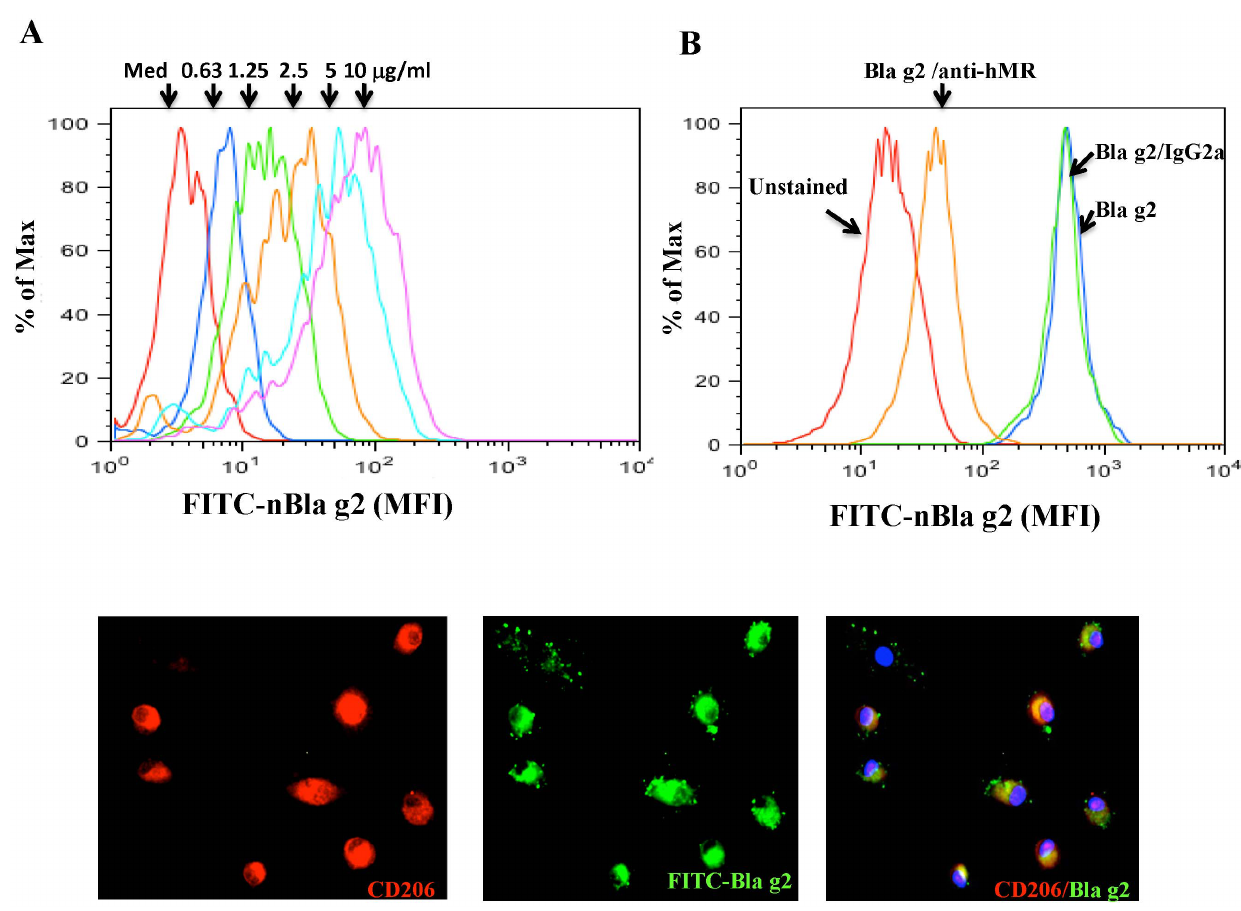
Figure 4. CD206 mediates Bla g 2 uptake by fibrocytes. ( A ) Different doses of the FITC labeled purified Bla g 2 were co-incubated with fibrocytes for 1 h at 37 u C, Bla g 2 uptake was detected by flow cytometry (Colors represent different doses as indicated). ( B ) The Bla g 2 uptake (blue line) was significantly inhibited when cells were pre-incubated with CD206-blocking anti-hMR (orange line) for 1 h at 37 u C, but not with isotype (IgG2a, green line). ( C ) Co-localized Bla g 2 and CD206 in fibrocytes was detected by confocol microscopy. Nuclear DNA was stained by DAPI (original magnification x40). Figures are representative of three independent experiments.